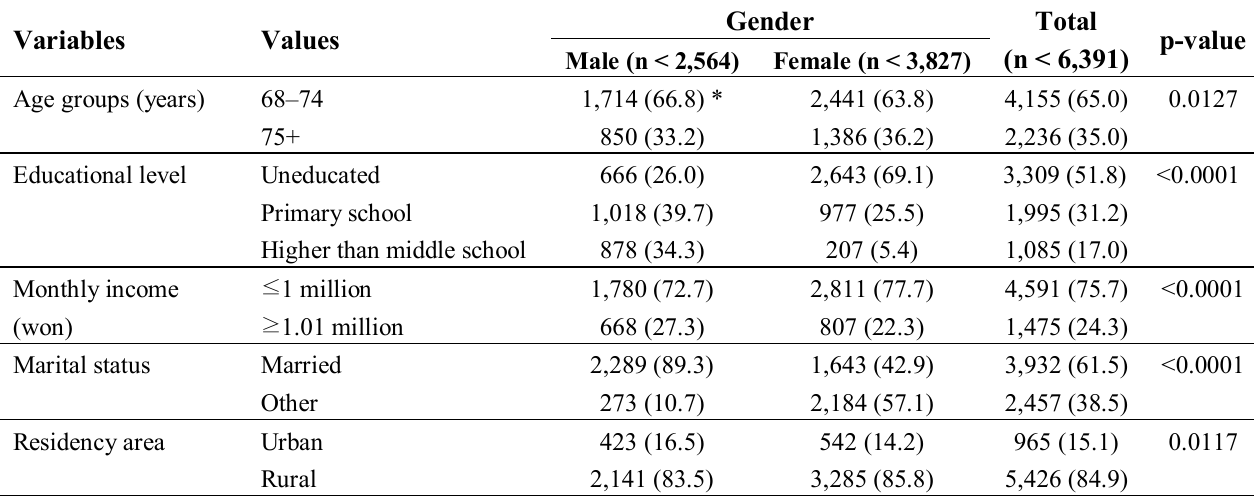
Table 1. Distribution of socio-economic factors among the older adults in relation to gender.